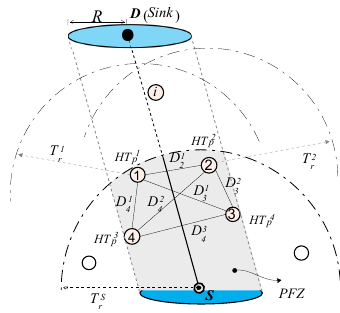
Figure 1. Holding Time and PFZ scenario.